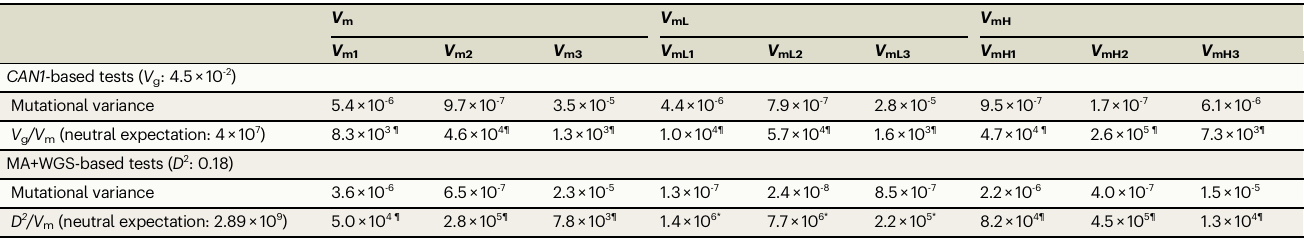
Table 1 | Test of stabilizing selection of the mutation rate in yeast.